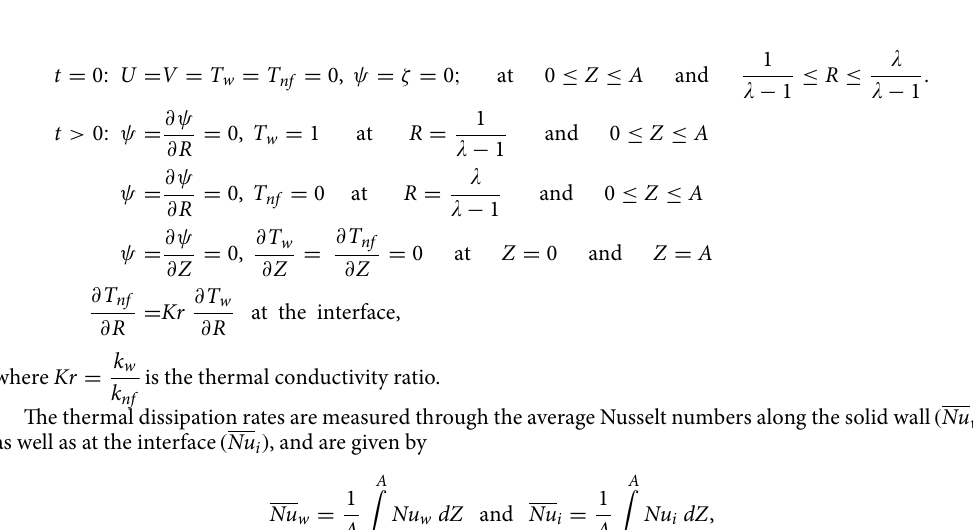
6 , ε = 0.4 , Kr = 10 and φ = 0.2 .